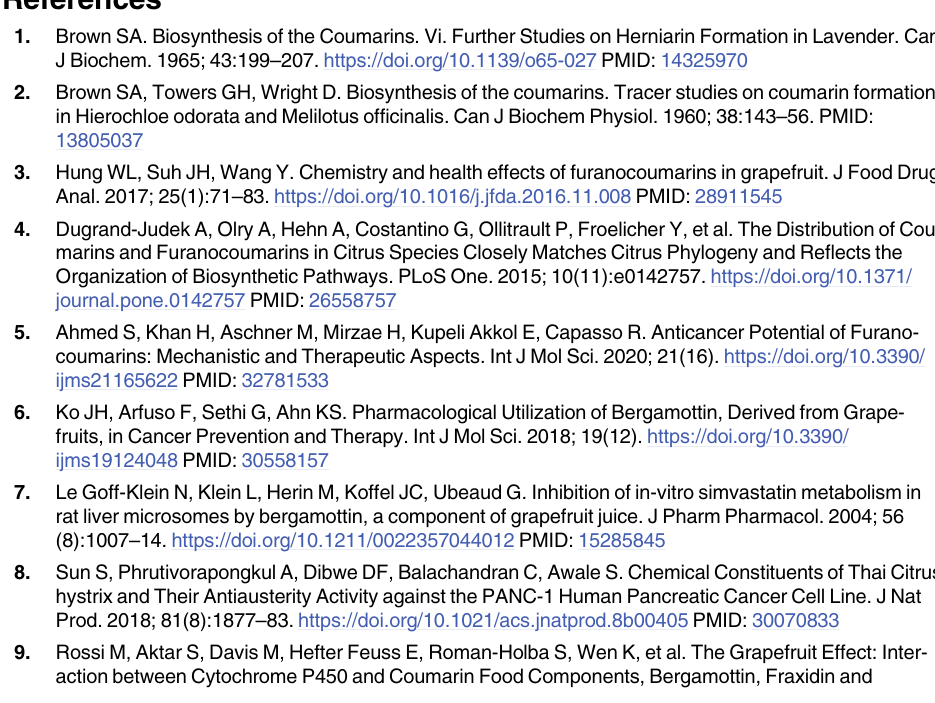
S1 Fig. Uncropped confocal images of Fig 2C and 2D. A z-Stack passing through the middle of the nucleus showing uncropped images corresponding to Fig 2C (LNCaP) and 2D (MDAP-